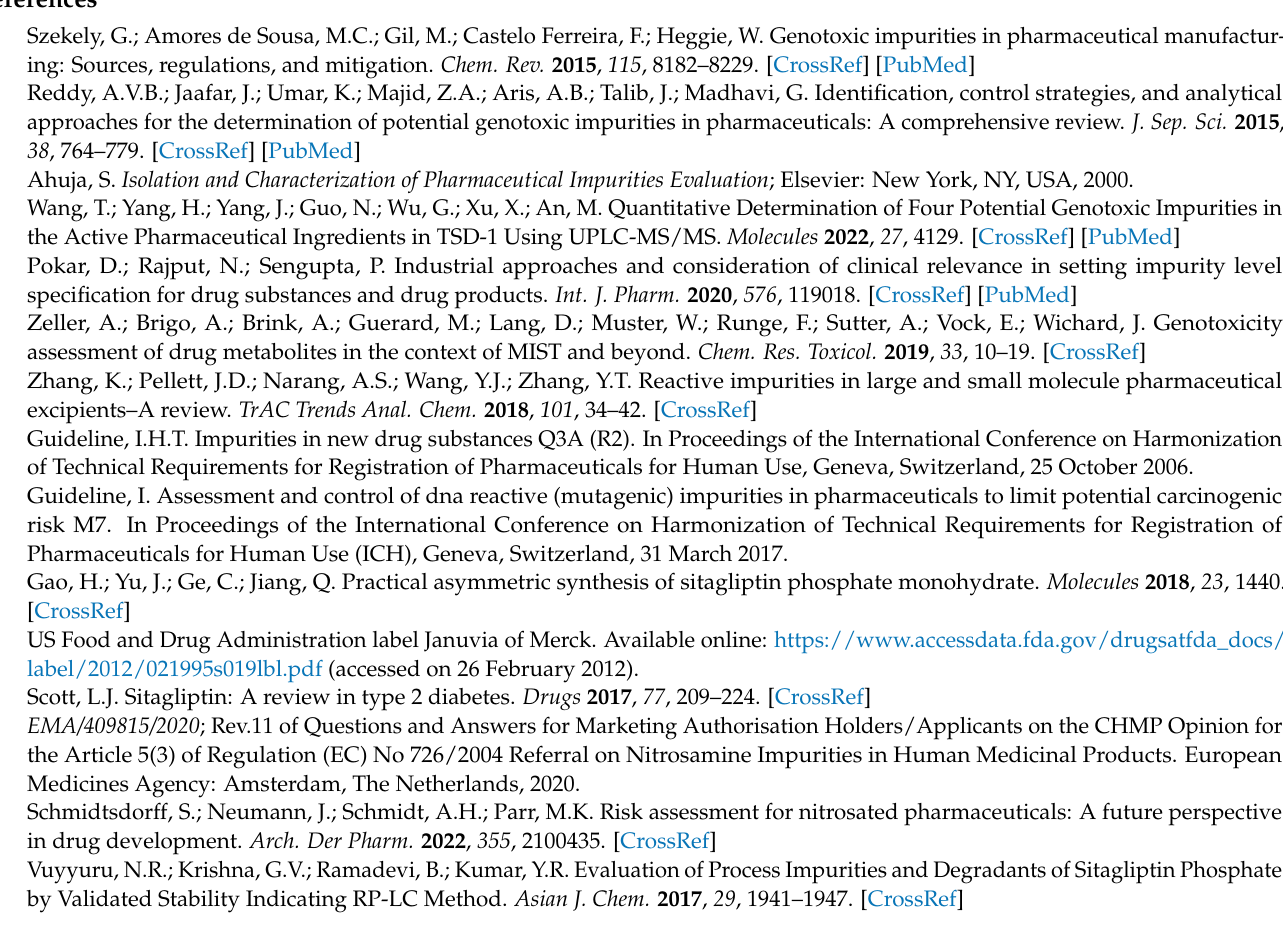
purity by HPLC chromatogram; Figure S17: 7-nitroso impurity Mass spectrum; Figure S18: 7-nitroso impurity 1H NMR spectrum—1; Figure S19: 7-nitroso impurity 1H NMR spectrum—2; Figure S20: 7-nitroso impurity TGA graph; Figure S21: Probable Fragmentation pattern of 7-nitroso impurity in the mass ionization chamber due to parsing